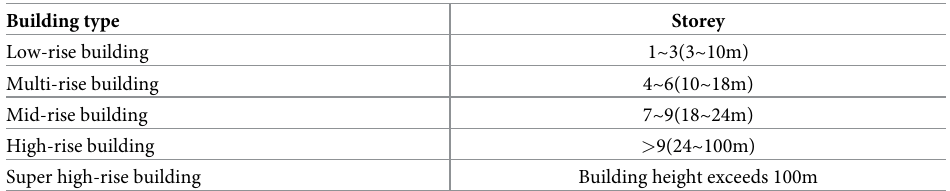
Table 1. Classification of building types.